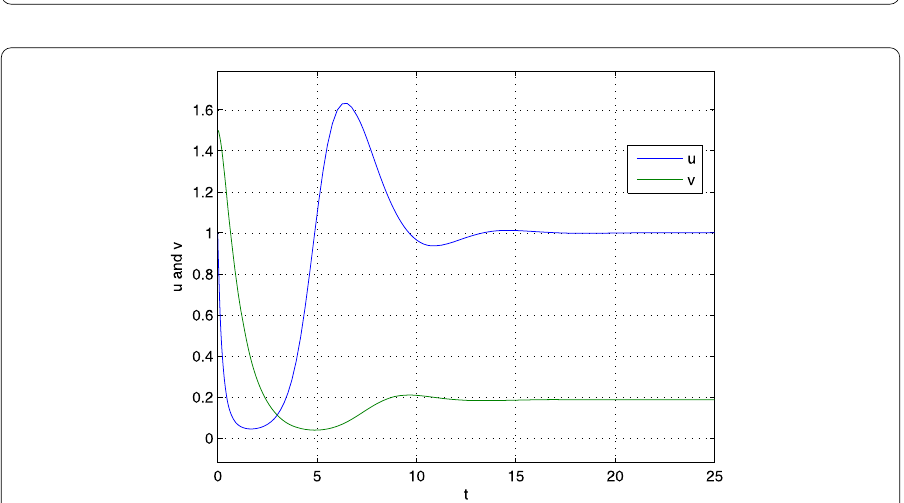
Figure 14 Dynamic behavior of system (1.1) with r 0 = 4, d = 1, a = 1, p = 2, E = 1, m 1 = 1, m 2 = 0.1, c = 0.5, q = 1.1, and k = 0